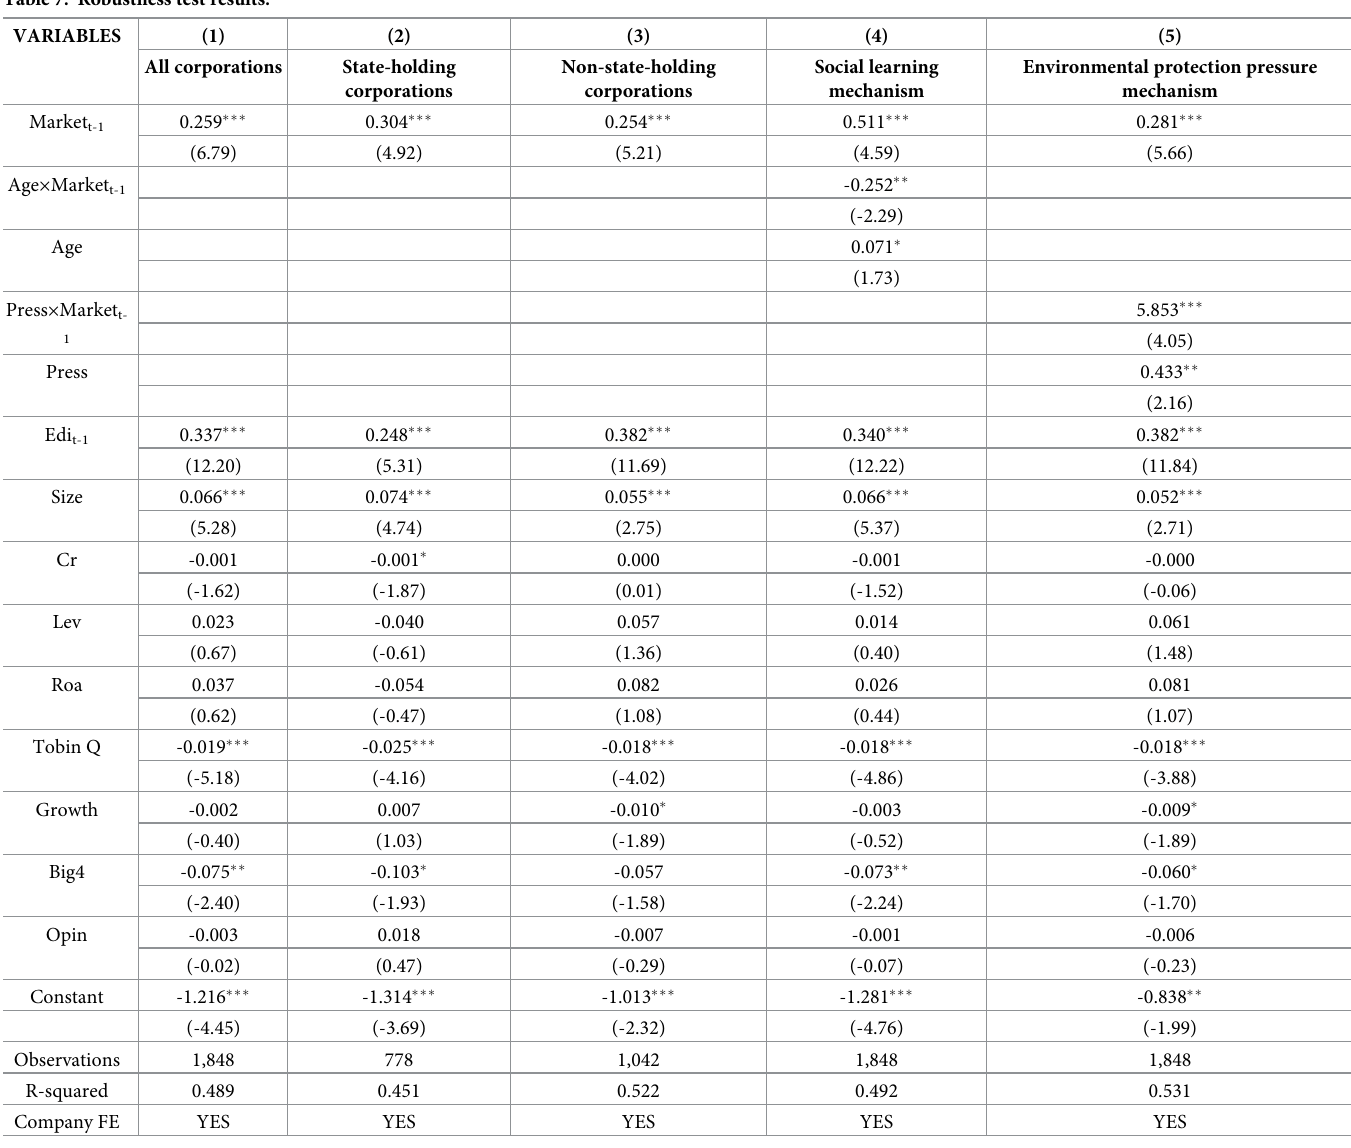
Table 7. Robustness test